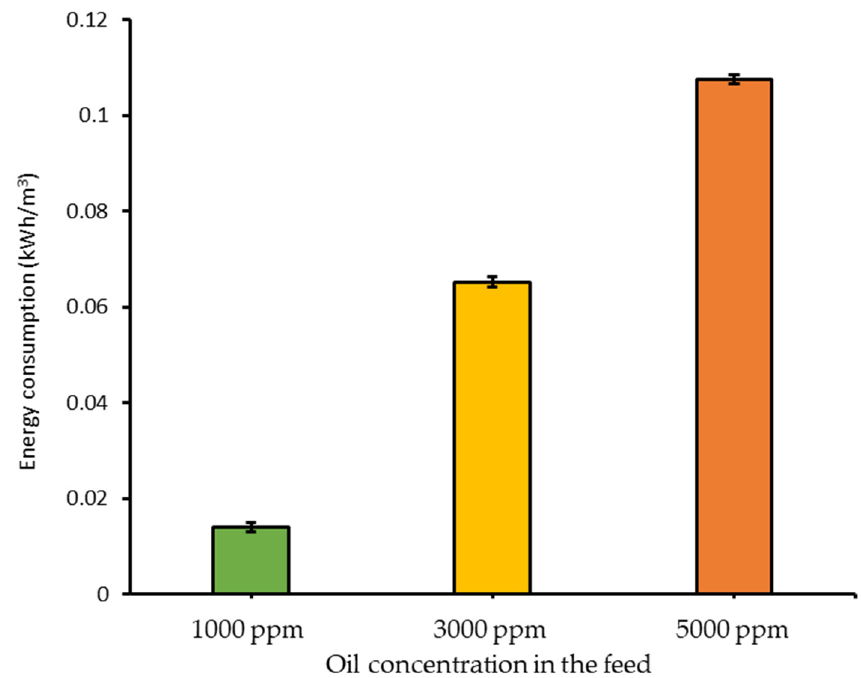
Figure 7. Effect of oil concentration in the feed solution on the specific pumping energy consumption using PSF/PEG-60 under transmembrane pressure of 0.2 bar. The energy consumption estimations were done using permeability data at the final reading of the first filtration cycle.